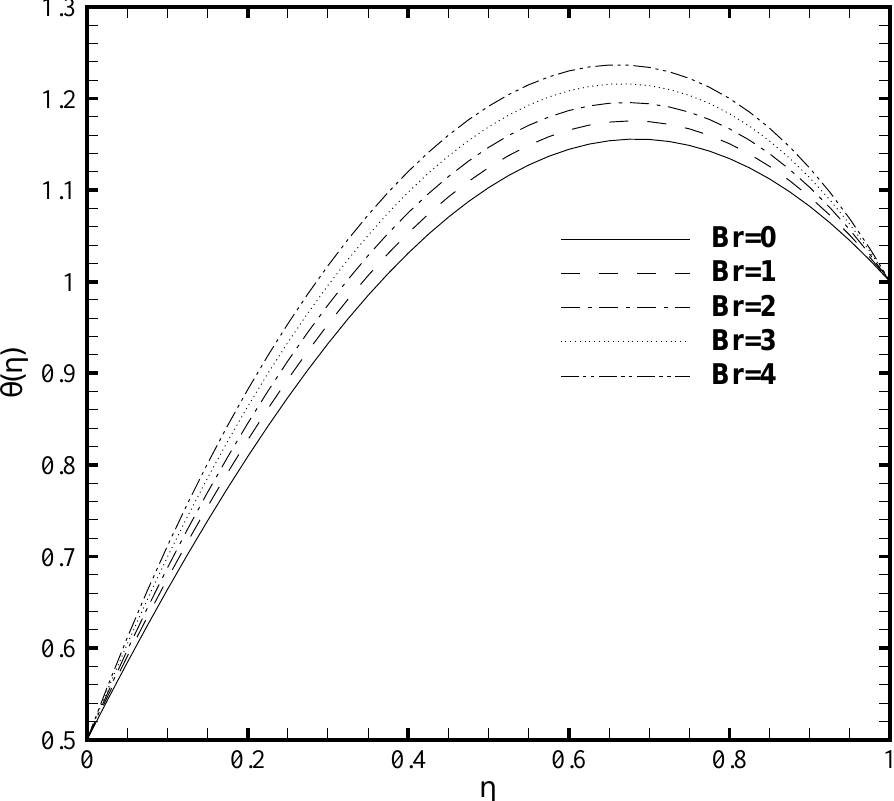
Figure 5. Temperature profile θ ( η ) for several values of Brinkmann number Br when ζ = P = κ = Ha = δ θ 2 = F k = 1, N b = 0.2, N t = 0.1, β = 0.05 and δ θ 1 =